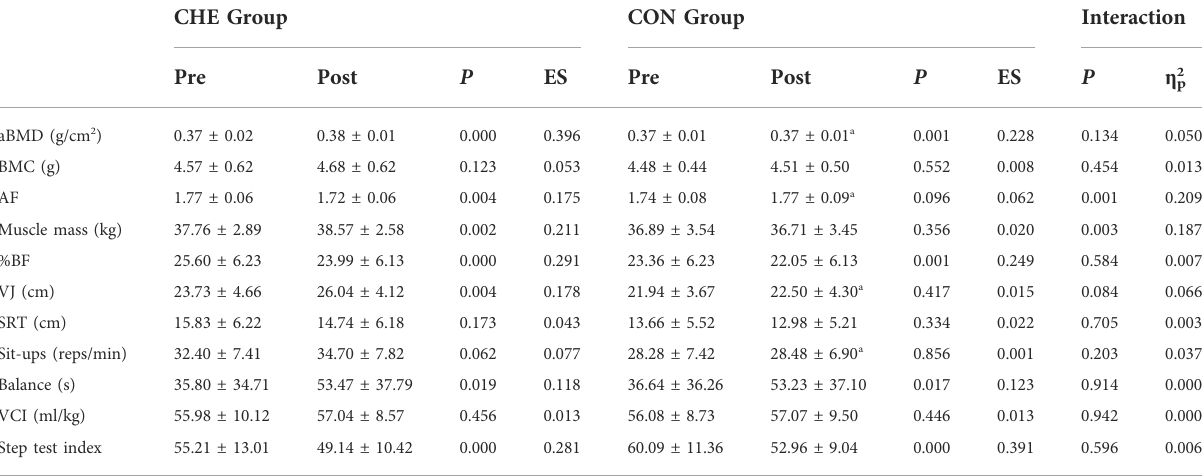
TABLE 3 AF, aBMD, and physical fi tness in the pre-and post-intervention. CHE Group CON